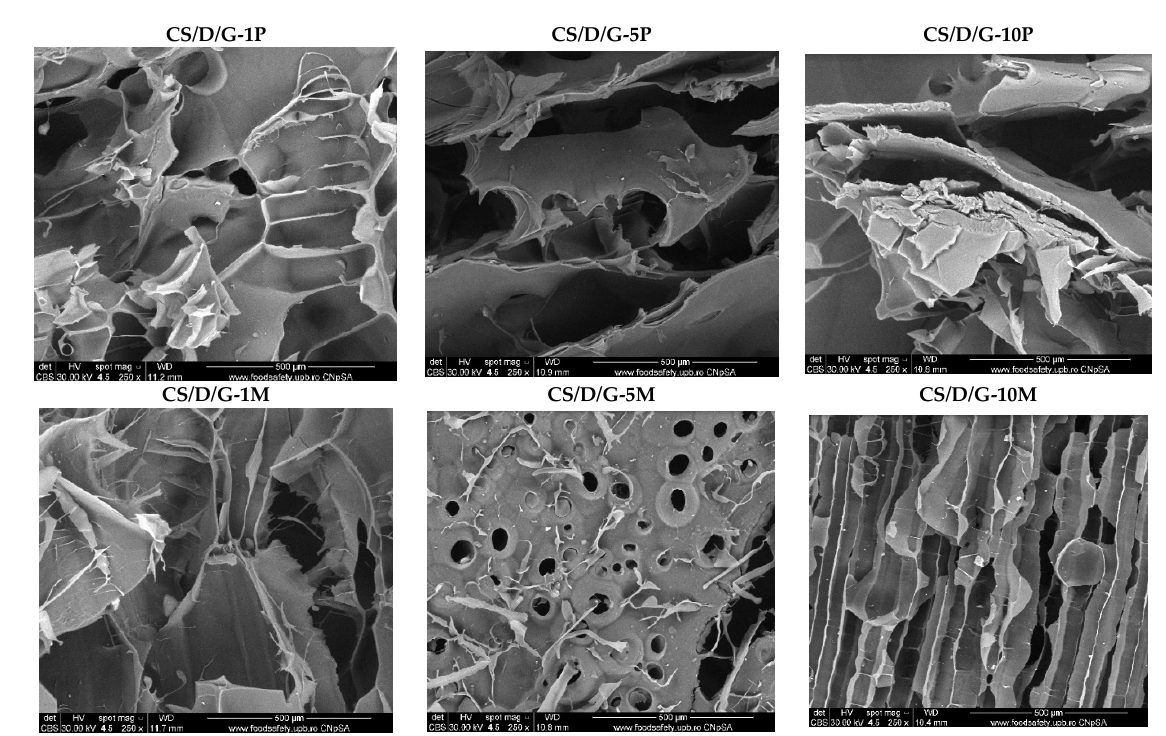
Figure 5. SEM images of the CS/D/G hydrogels (CBS